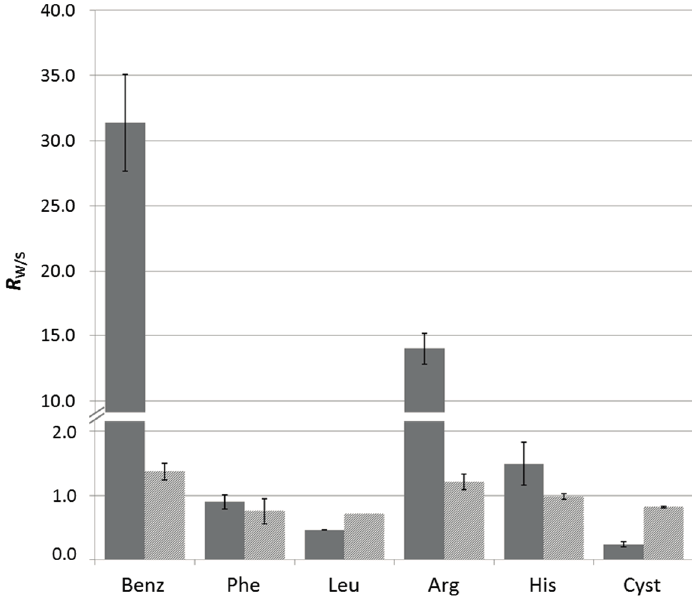
Figure 2. Selective retention of aminated products ( R W/S ) with different amino acids in the presence of either cellulose (light grey) or dT n on cellulose (dark grey). Error bars represent the standard deviation.